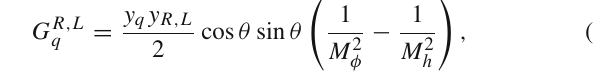
Fig. 5 Left: The relic abundances of the Majorana fermions (67) normalized by the observed value (23) as a function of g X ( M pl ) for a fixed value of ξ = y R ( M pl )/ y L ( M pl ) . The star points are located at the typical values of g X ( M pl ) satisfying (cid:14) DM ˆ h 2 =